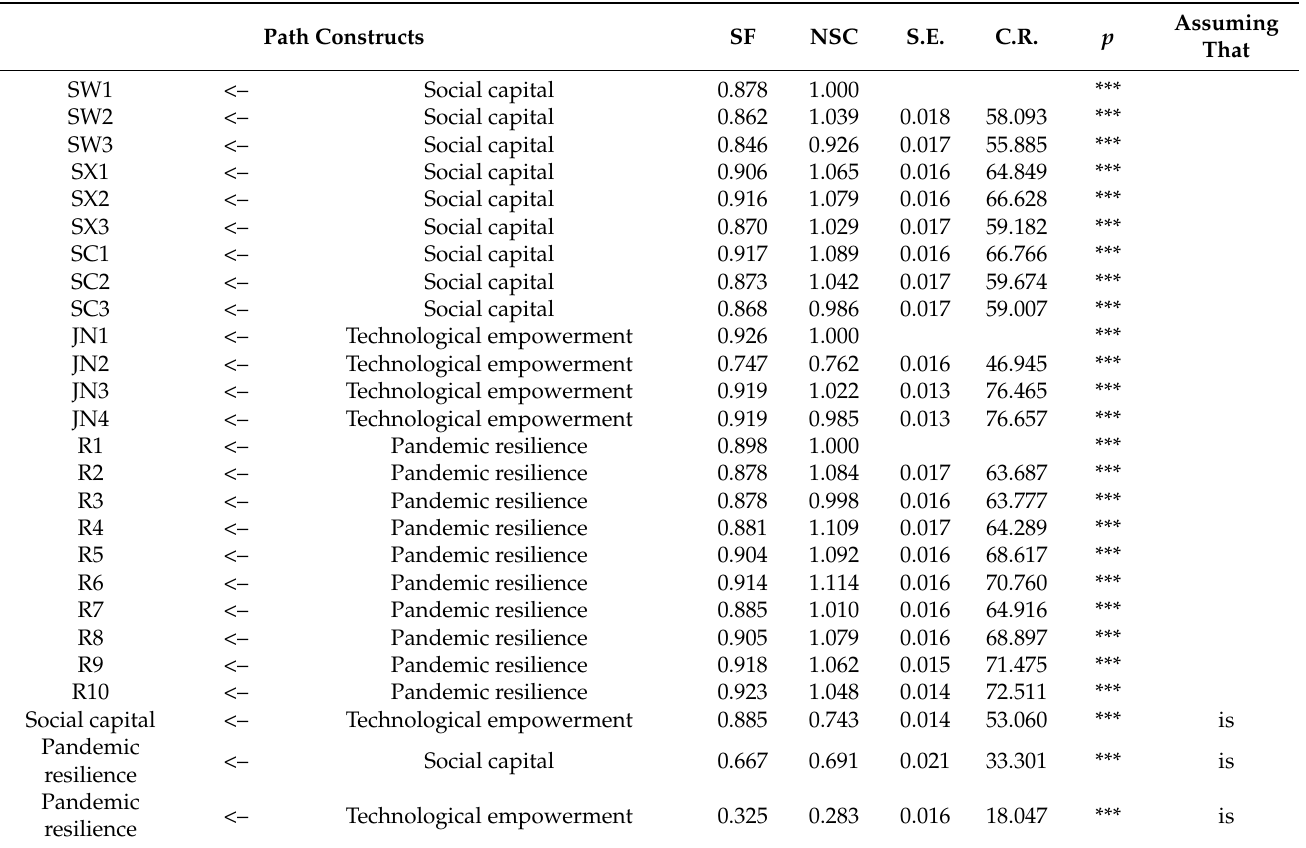
Table 6. Path coefficients for the hypothetic model towards